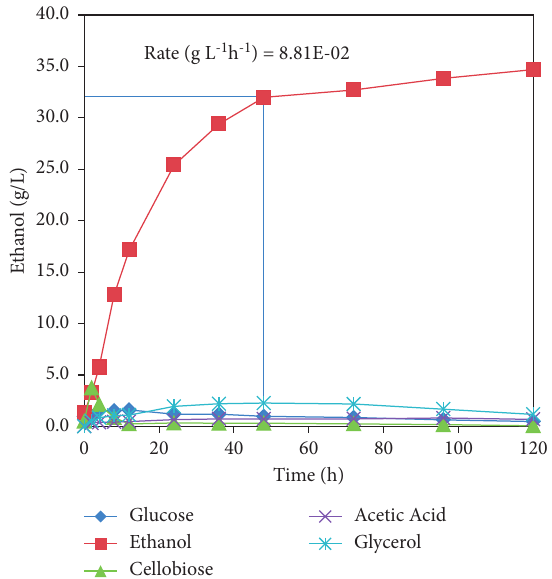
Figure 1: Cellulosic ethanol production using Clavispora NRRL Y- 50464 from standard DOE-NREL-pretreated corn stover with a 20% solids loading (equivalent to 7.57% cellulose) by simultaneous saccharification and fermentation using 2-L bioreactors. Values of ethanol production are means of three replications with a standard deviation of 0.05g/L at 48 h and ranged from 0.02 to 0.24g/L for all time points